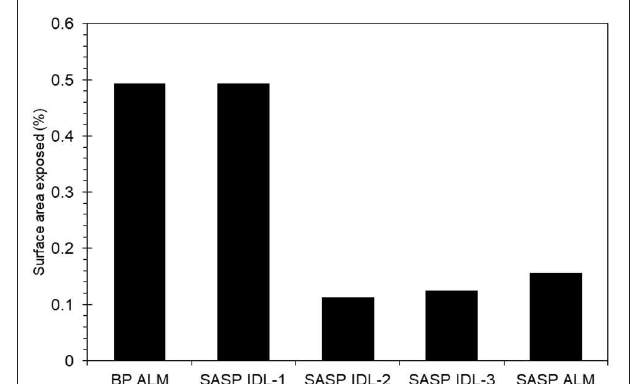
FIGURE 5 | Surface to volume ratios of the snow phase in the Berthoud Pass merged layer sample, and the Swamp Angel Study Plot individual dust layer and Swamp Angel Study Plot merged layer samples, denoted by BP ALM, SASP IDL, and SASP ALM, respectively. Subsamples of SASP IDL samples are denoted 1–3.